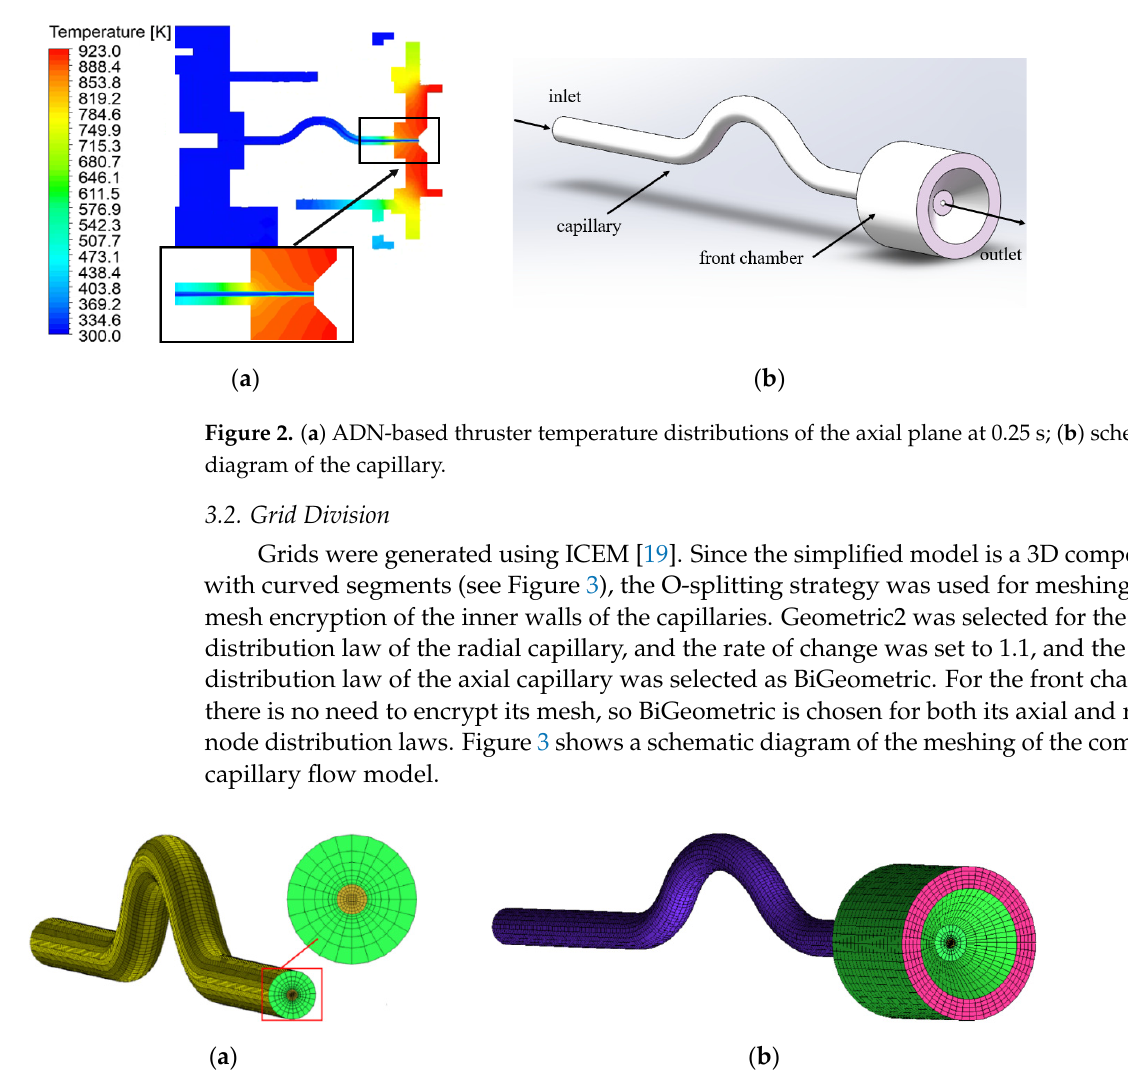
Figure 4. Comparison of bubble volume and relative deviations with different grid cell numbers. 4. Simulation Calculation Basics 4.1. Control Equations This study will use the NS-VOF model to simulate the flow of ADN-based liquid propellant in the capillary. Continuity equations for the gas and liquid phase are [20]: (